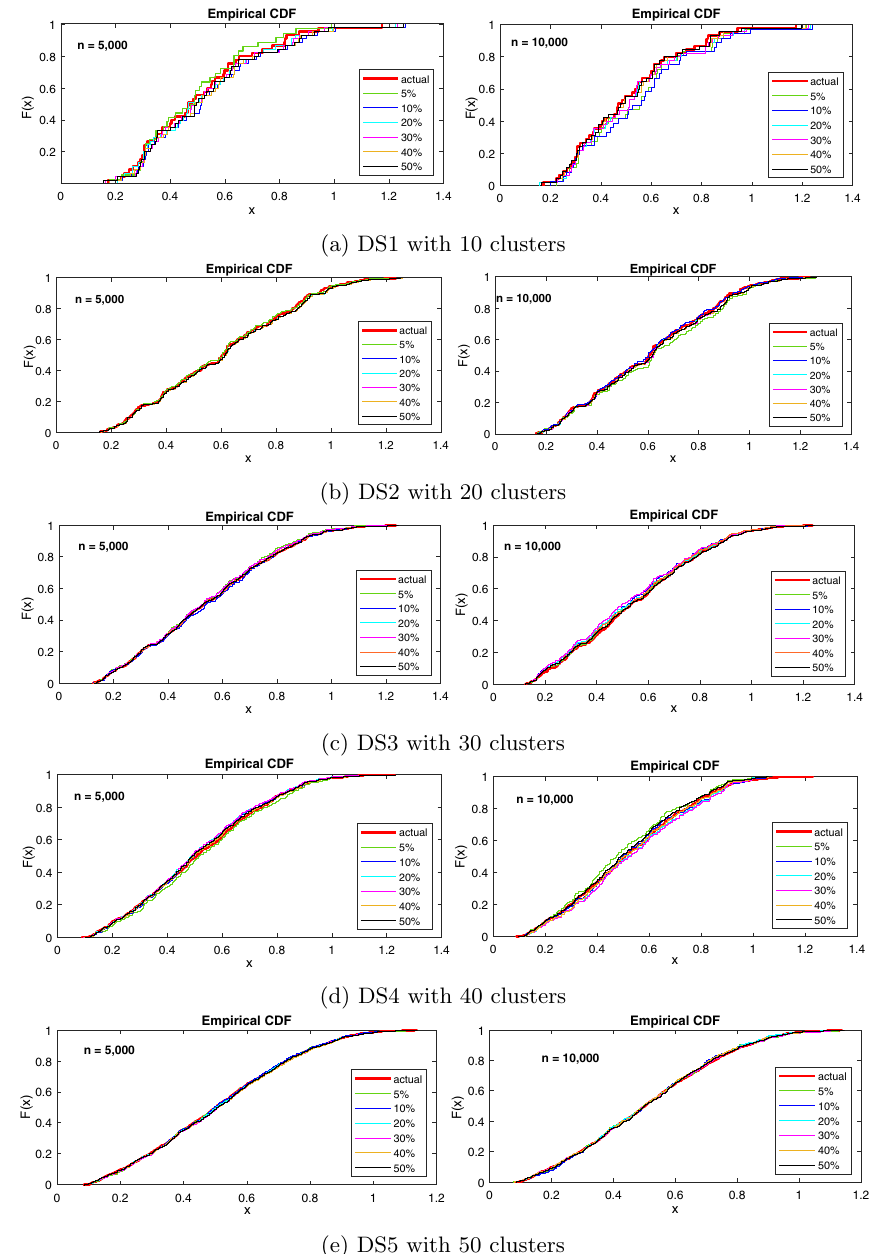
Fig. 6 The KS-test plots for comparison of actual centers’ distance distribution versus the distance distribution of the centers by the RSPCE algorithm. The left-plot uses sample size n uses n =